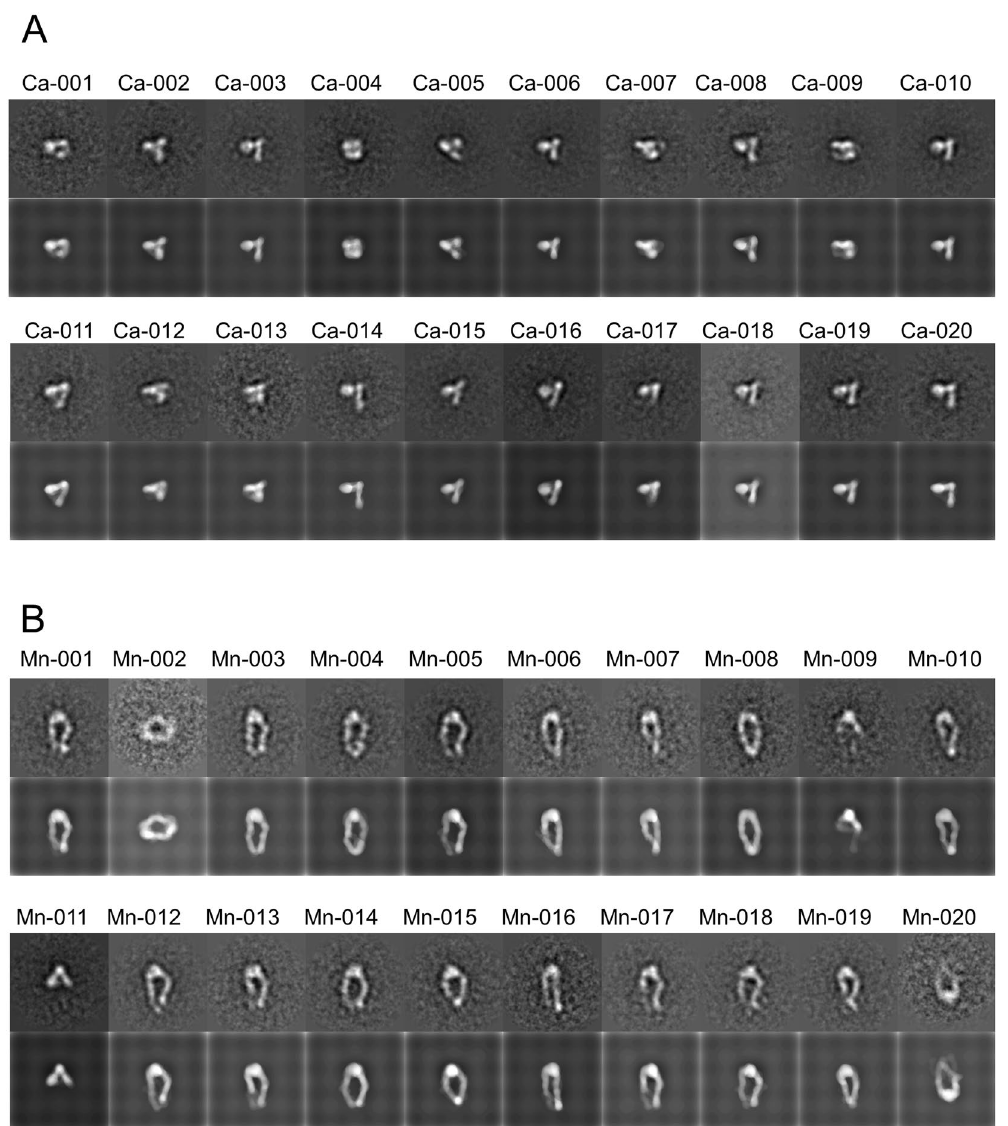
Figure 5. Combined negative stain models for reproducing experimental EM images of integrin in ( A ) Ca 2 + and ( B ) Mn 2 + solutions. The experimental EM image is shown above each model for comparison. The label of each EM image is also